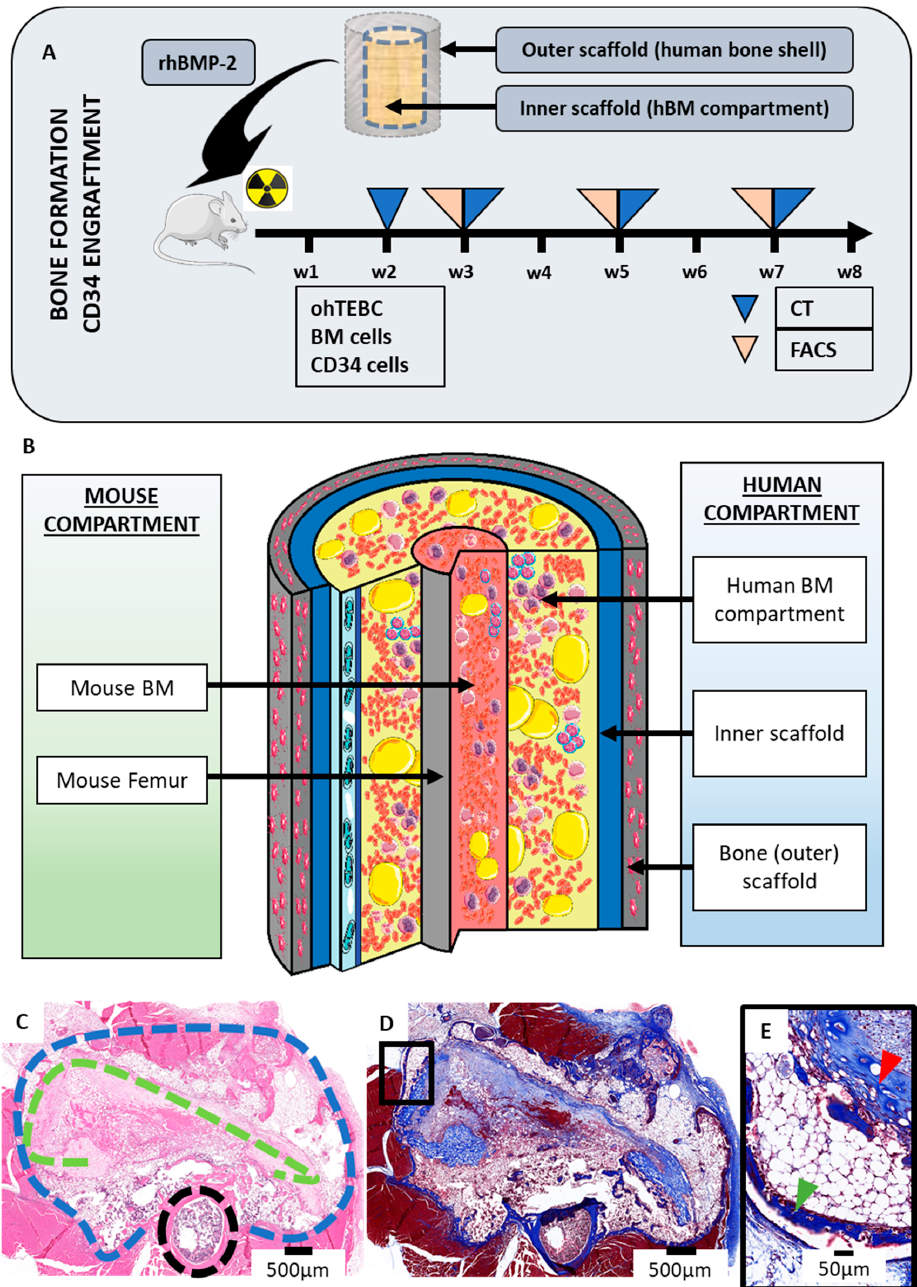
Figure 2. The establishment of the ohTEBC results in the formation of a bone organ within the mouse. The double coaxial sca ff old construct was implanted orthotopically with rhBMP-2 around the femur of previously irradiated NSG mice. Bone formation was monitored by in vivo CT scans and engraftment of the CD34 + cells was measured by flow cytometry every 2–3 weeks ( A ). After in vivo implantation, the construct contained an hBM compartment within the bone cortical shell formed by the sca ff old containing the pre-cultured hOBs ( B ). Representative histological cross sections of a construct. The H&E staining ( C ) allows di ff erentiation between the outer bone sca ff old (blue dashed line), the inner sca ff old that formed the hBM compartment (green dashed line) and the murine femur (black dashed line). Masson’s trichrome staining ( D ) demonstrates deposition of the ECM in the construct, depicting collagen in blue. Zoomed-in detail of an area of Masson’s trichrome staining showing the outer and inner sca ff olds, indicated by the green and red arrowheads, respectively ( E